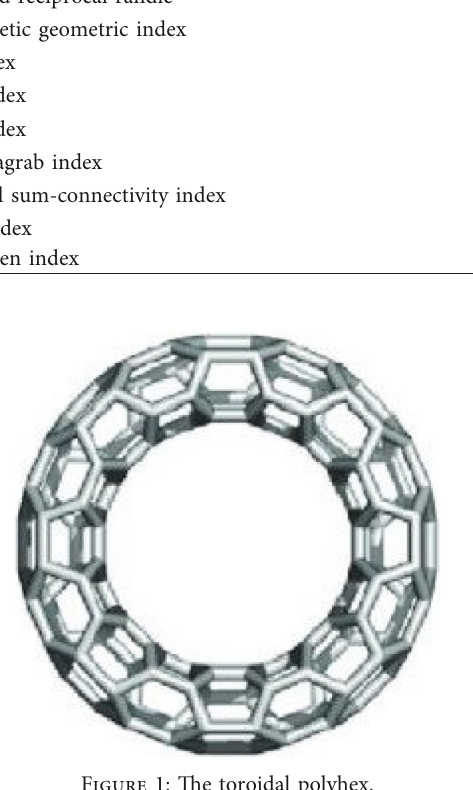
Figure 2: Plot of M-polynomial of toroidal